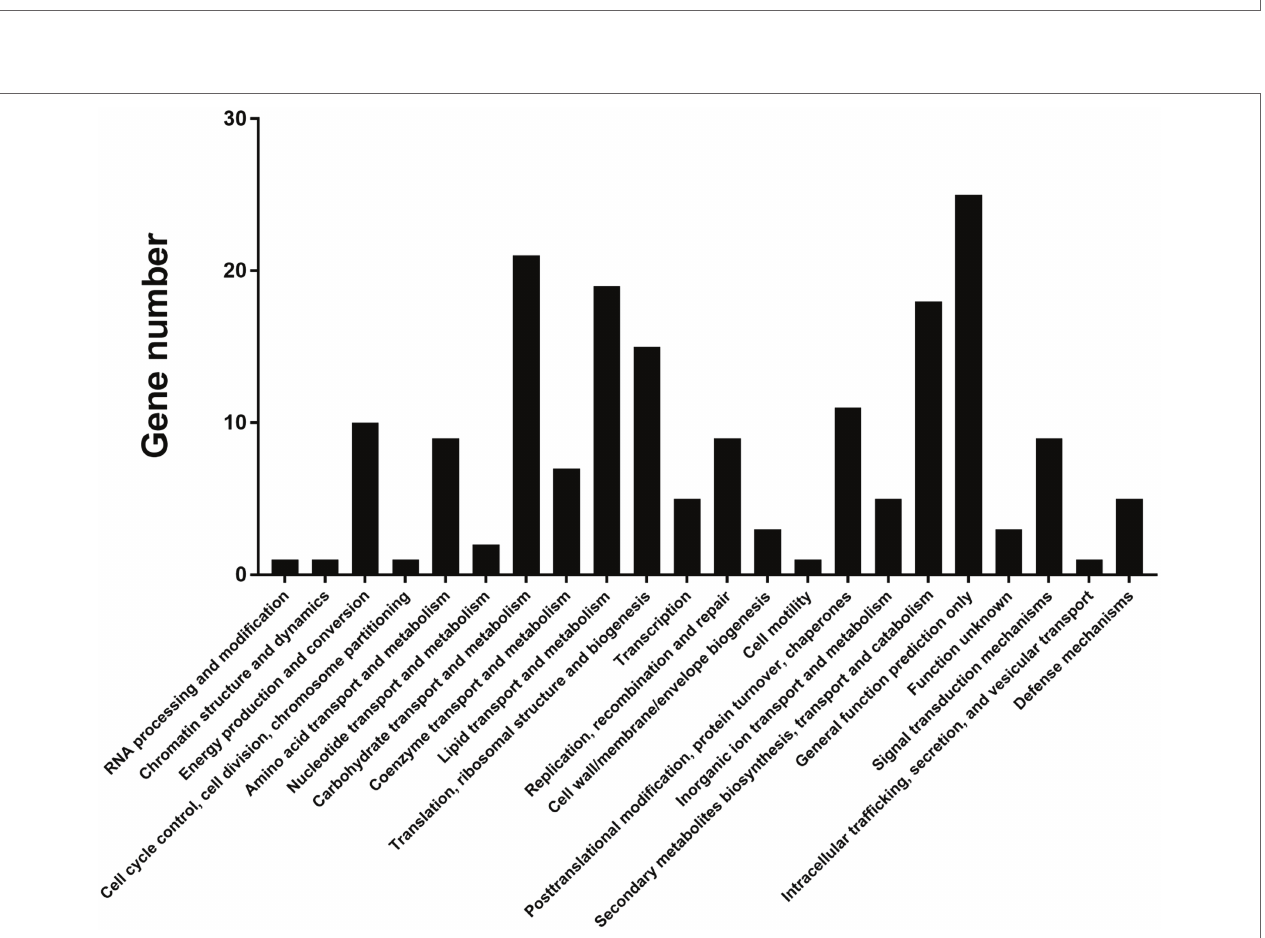
FIGURE 5 | COG annotation of the predicted target genes. Approximately 148 target genes have COG terms. COG terms are indicated on the image. X -axis: COG classes. Y -axis: shown in the